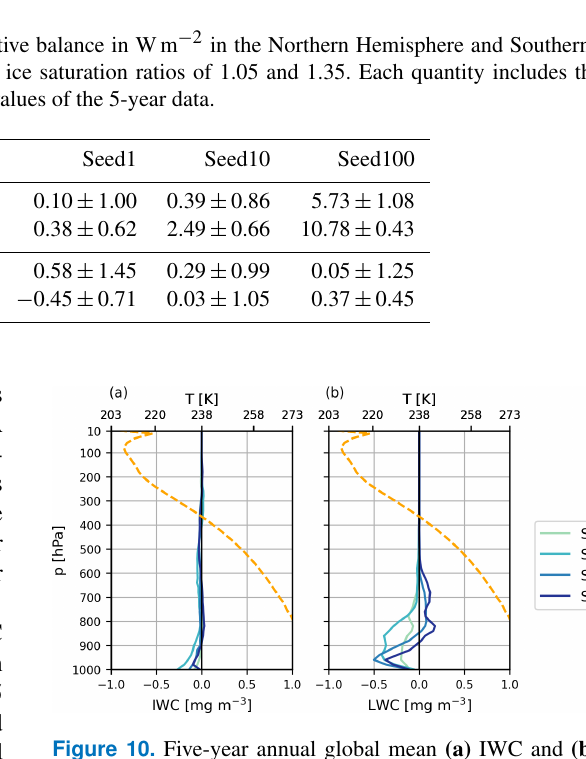
Figure 10. Five-year annual global mean (a) IWC and (b) LWC anomaly profiles in mgm − 3 as in Fig. 7 but for S i,seed =